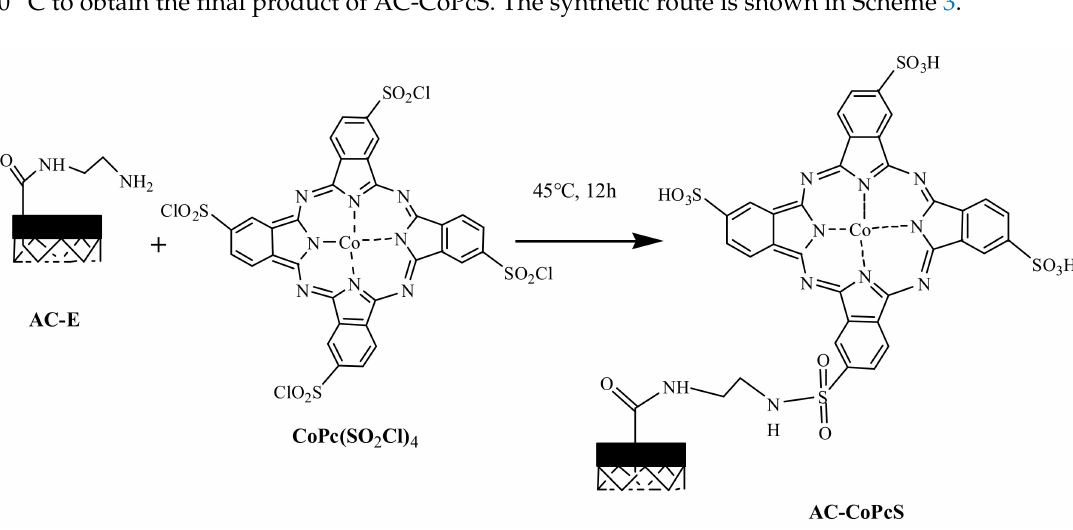
Scheme 3. Schematic representation showing the preparation of AC-supported sulfonated cobalt phthalocyanine